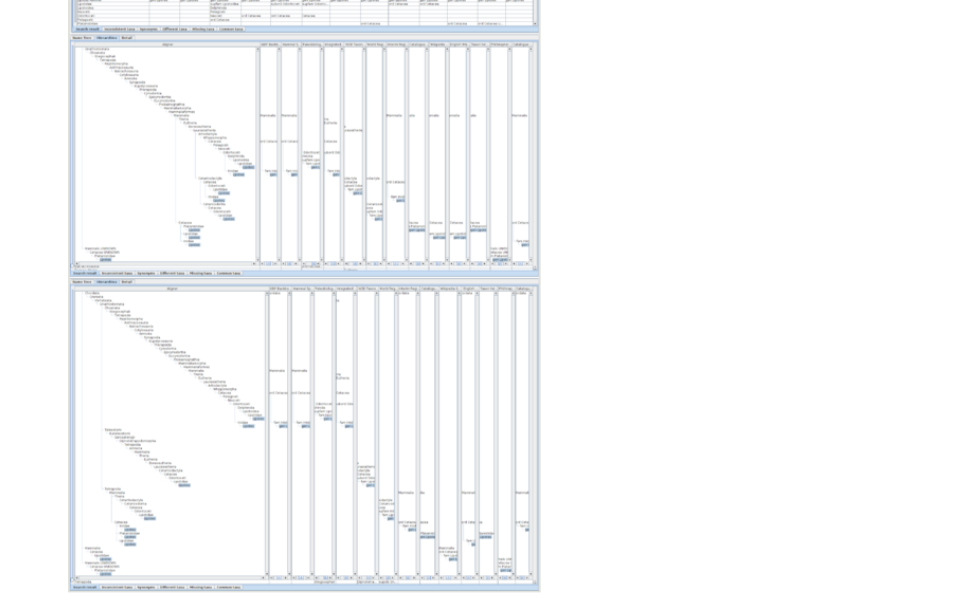
Figure 10. Alignments with di ff erent height of hierarchies containing Lipotes , up to order (upper), class (middle) or phylum (bottom), respectively. The height and depth of hierarchies being compared can be speci fi ed in the name usage list pane by either rank or number of levels above and below the name usage. If speci fi ed by rank, the software composes hierarchies to be limited within less than the next rank. For example, if class is speci fi ed as upper limit of hierarchies, the results may contain name usages less than phylum to cope with unranked intermediate name usages. The aligner tree for hierarchies up to order has four branches containing Lipotes . One branch is an artefact of misinterpreted data, Cetacea UNKNOWN, where UNKNOWN should be processed as authority rather than a part of name literal itself. Other three branches are results of di ff erent family names which require independent path between order and genus. The aligner tree for hierarchies up to class contains 9 Lipotes branches. Besides the erroneous UNKNOWN branch, remaining eight branches are joined into three higher branches depending on intermediate taxa between Mammalia and Cetacea, i.e. without intermediates, via Artiodactyla or Cetartiodactyla. Note that hierarchies without intermediates are mapped to branches in aligner tree either with or without intermediates depending on the sequence of integration into the aligner tree, because addition of an inconsistent path to the aligner tree requires the choice of one of those paths to which a new direct hierarchy is mapped but there is no way to choose one of them. The aligner tree up to phylum also contains 9 branches of Lipotes including one erroneous 'UNKNOWN'. Although the number of branches is the same to that for class, branching points get